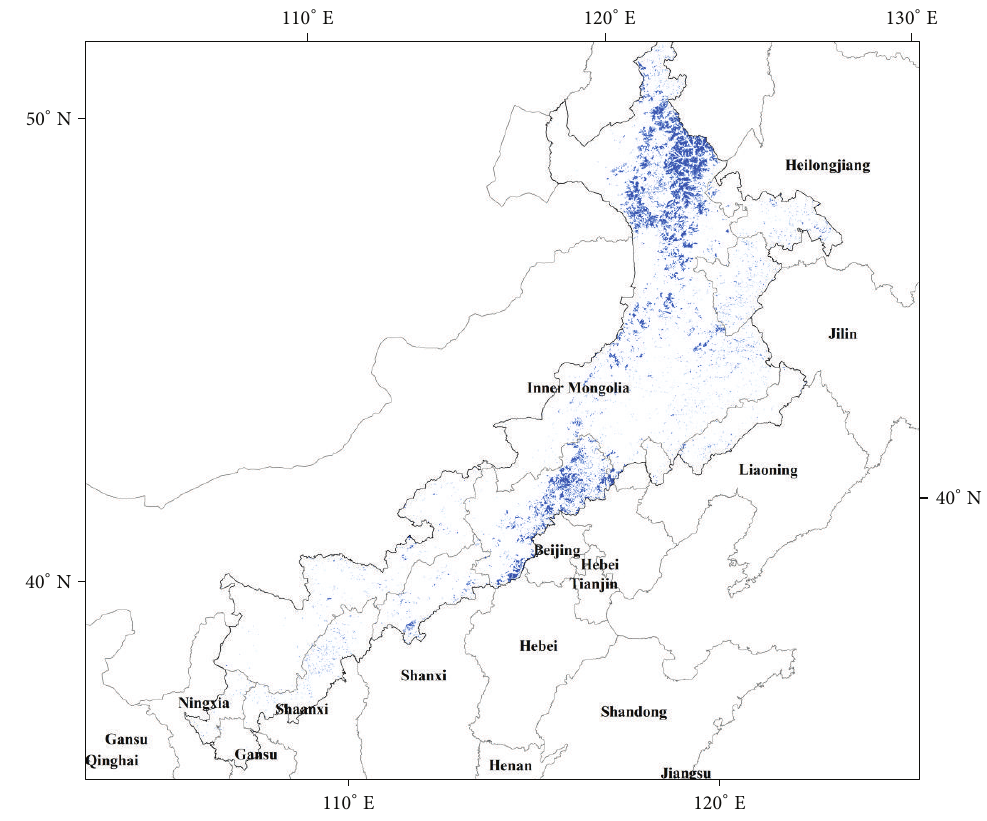
Figure 4: The agreement grids of classification among GLC, UMD, IGBPDIS, and